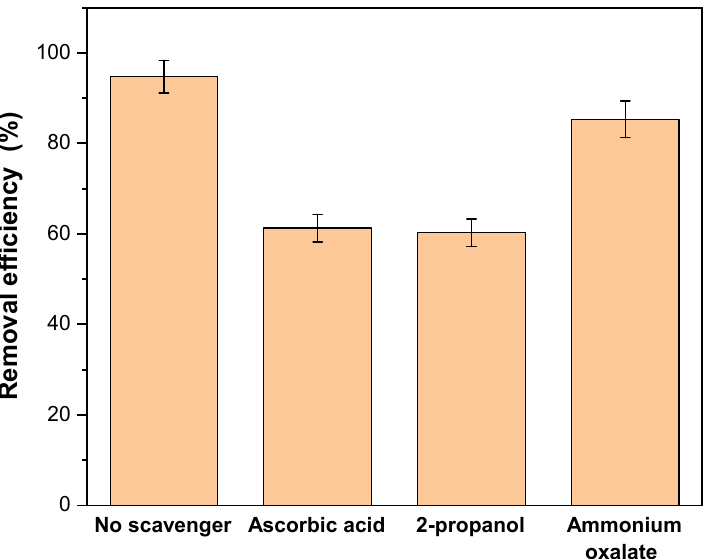
Figure 13. Role of radical scavengers in the photocatalytic removal of MB with B–ZnO/TiO 2 (initial MB concentration: 15 mg/L; concentration of all scavengers: 1 mmol/L; photocatalyst amount: 30 mg; pH: 11; irradiation time: 15 min).